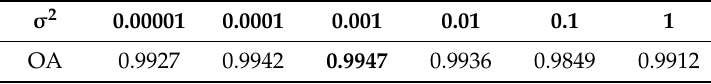
Table 4. OA values vs. different noise variances in the virtual samples.